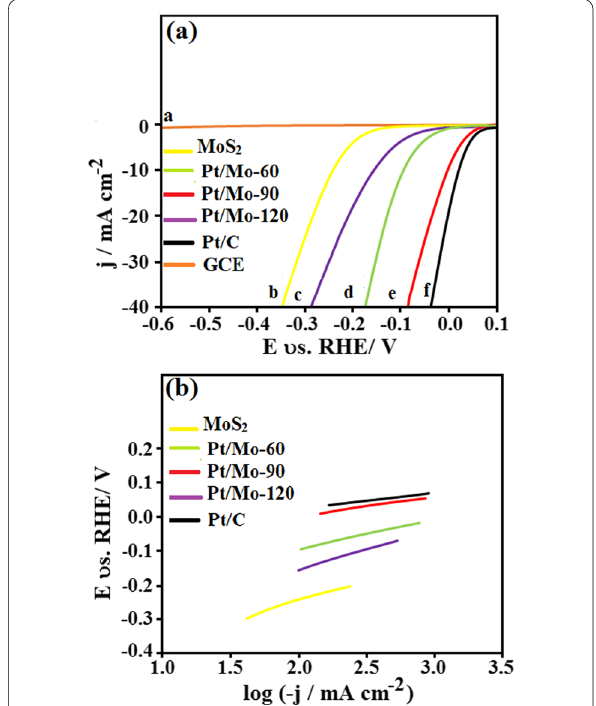
Fig. 6 a LSV curves of a bare GCE, b Pure MoS 2 nanosheets, c Pt/ Mo-120, d Pt/Mo-60, e Pt/Mo-90 composite, and f Pt/C; b Tafel plot of different